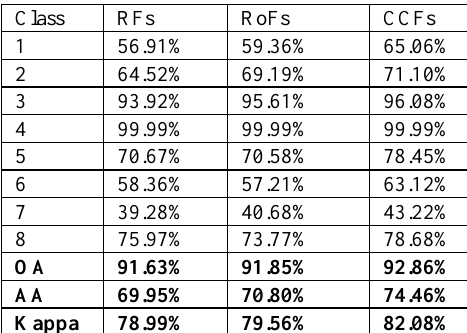
Table 4. Classification accuracies of RoFs and CCFs when compared to RF for all Pays of Brest (S1).